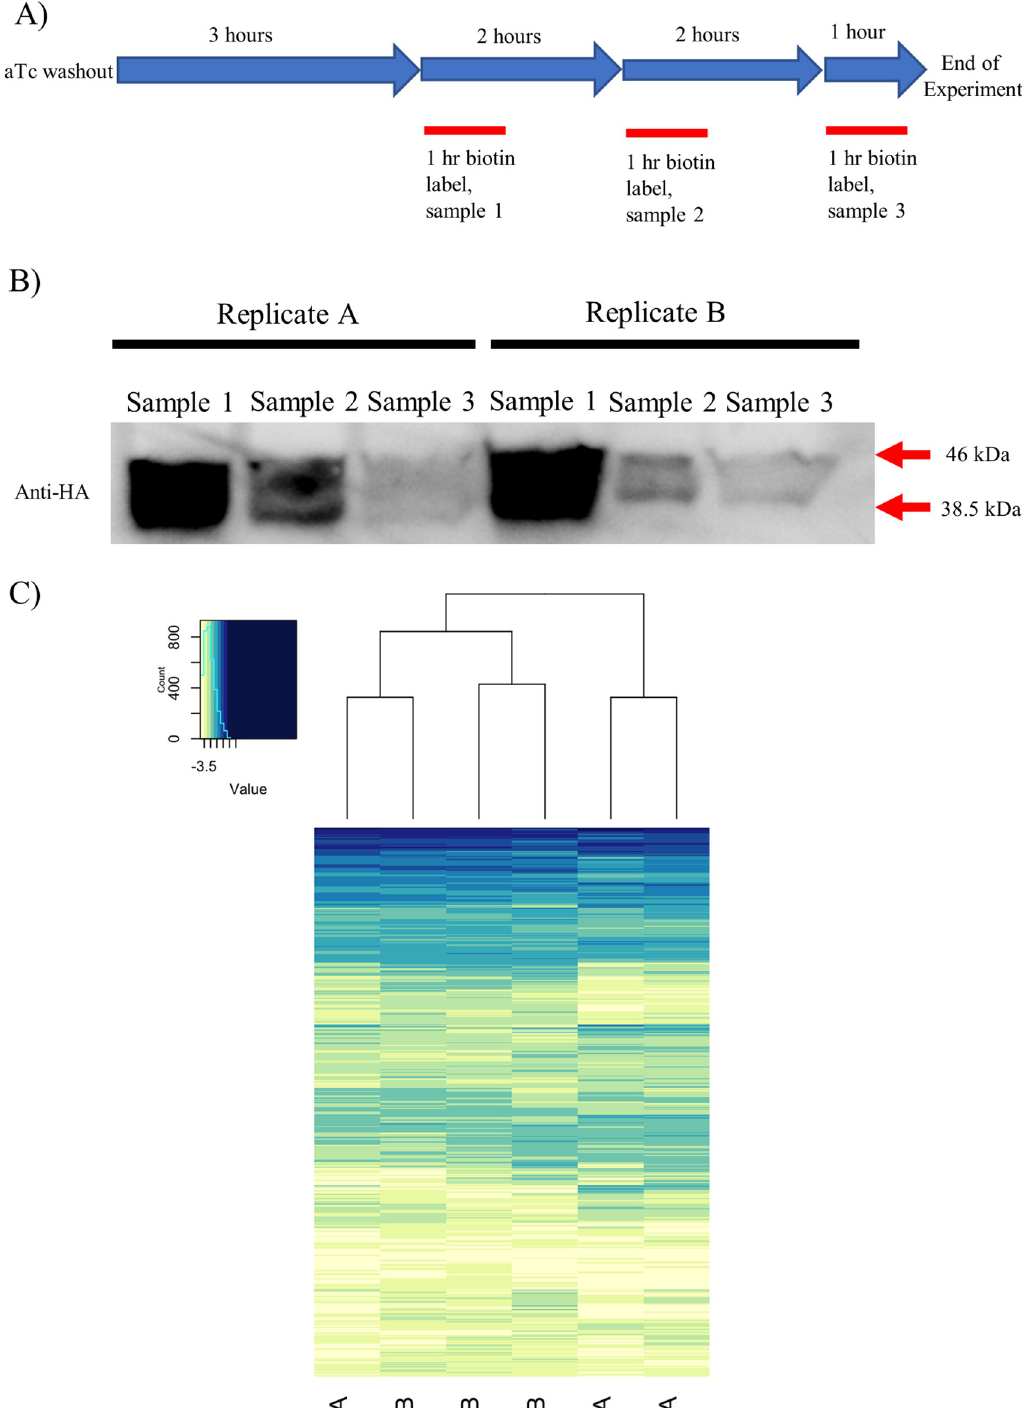
Fig 3. Protein biotinylation dynamics after different time periods of knockdown. A) Timeline of how these experiments were carried out (n = 2). B) Western blot analysis of Hsp60L-TurboID parasites knocked down for 4, 6, or 8 hours. 50 μ g of total protein was loaded for each sample. Note that Hsp60L-TurboID-3xHA runs as a doublet. The higher molecular weight band corresponds to full-length Hsp60L-TurboID-3xHA. The lower molecular weight band probably corresponds to TurboID-3xHA that has been imported to the mitochondrion with concomitant removal of the Hsp60 targeting sequence. C) Heat map of the